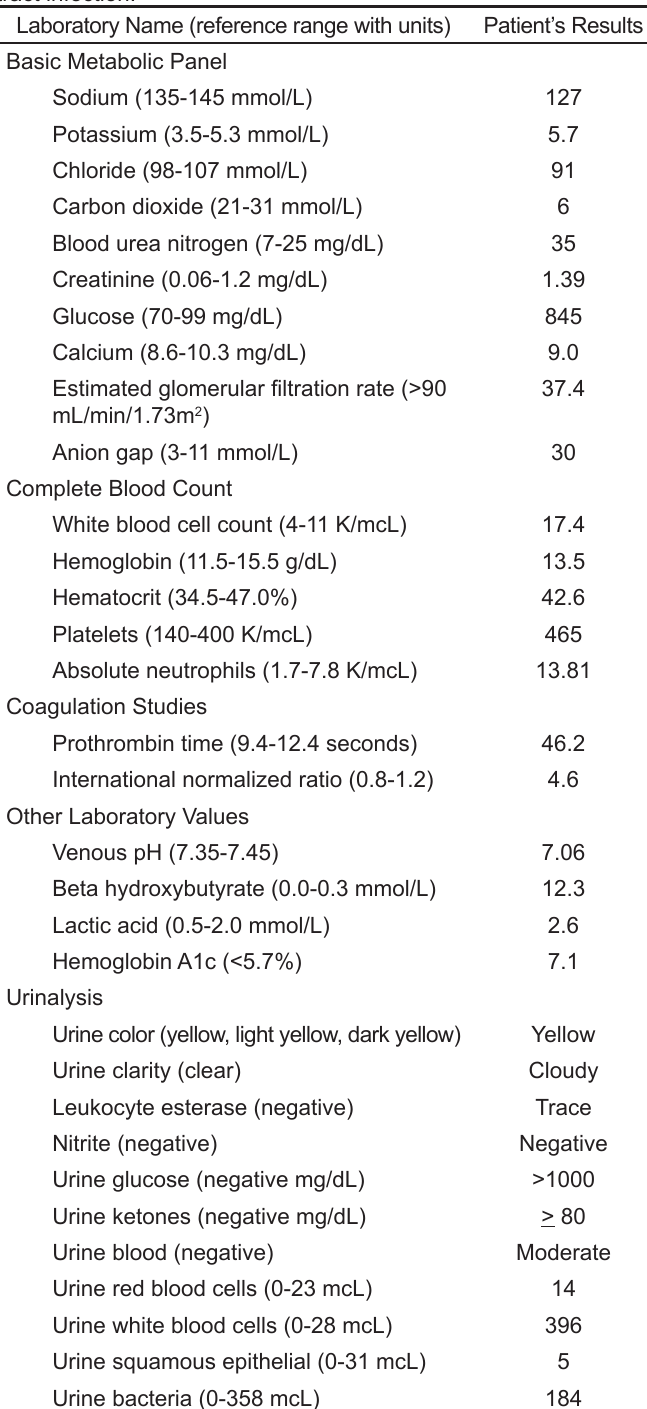
Table. Initial laboratory values of a patient with hyperglycemia, elevated anion gap metabolic acidosis, and evidence of urinary tract infection.